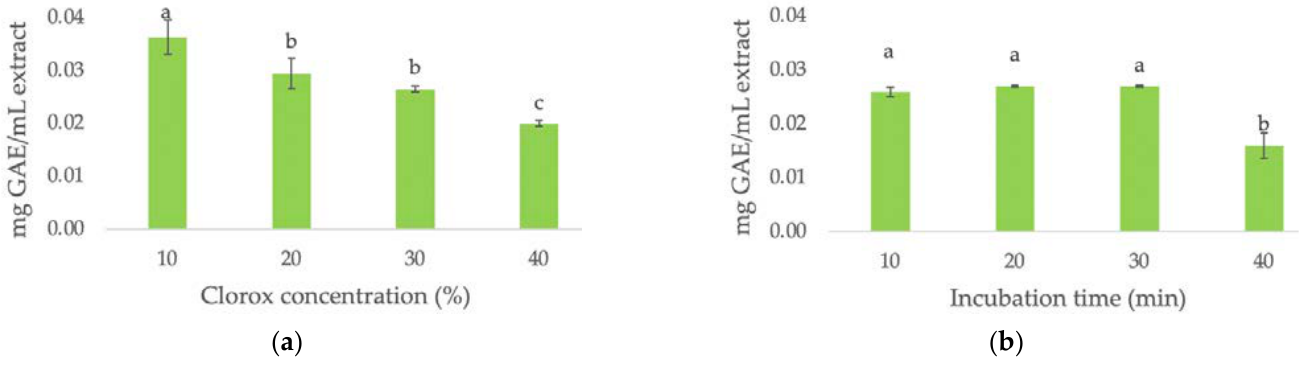
Figure 1. Effect of Clorox concentration ( a ) and incubation time ( b ) on phenolic content. Data with different letters (a, b, and c) indicate significant differences ( p < 0.05) between